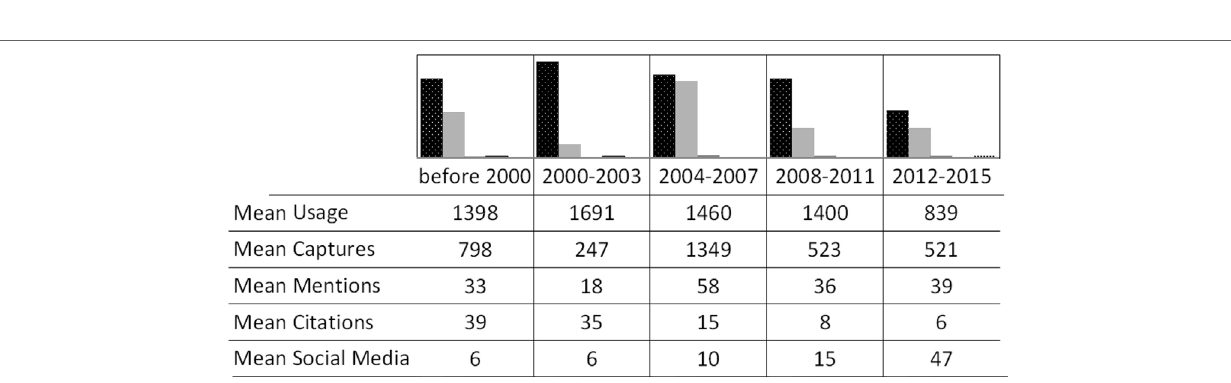
FigUre 4 | Percentage of availability and mean value for each dimension over the time. Book with data available (%) forms the five dimensions in PlumX. For more information and complete data, check Tables S3–S7 in Supplementary Material.